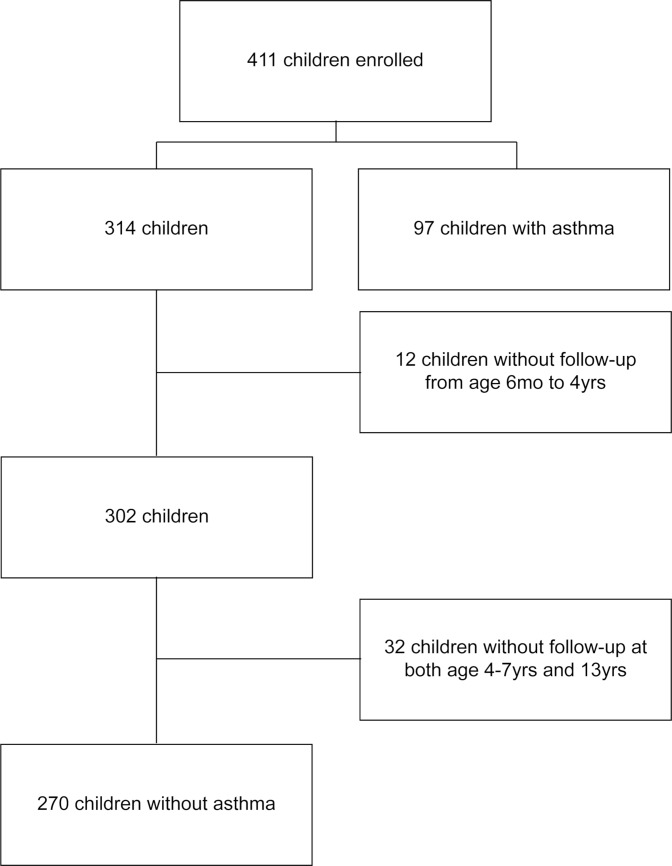
Flowchart of included children.